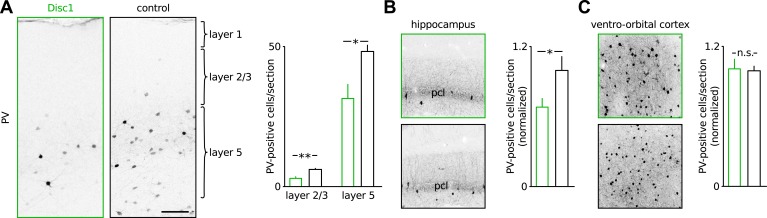
PV-positive INs are lost throughout cortical layers in the Disc1 PrlC.(A) Immunohistochemical staining of PV in the PrlC of a Disc1 and a control mouse. Scale bar: 100 µm. Right, quantification revealed reduced PV cell counts in layers 2/3 and 5 (n = 6 Disc1, 5 control mice). (B and C) Reduction of PV cells in the hippocampus but not ventro-orbital cortex of Disc1 mice. Pcl: pyramidal cell layer. *p < 0.05, **p < 0.02. Data are mean ± SEM.